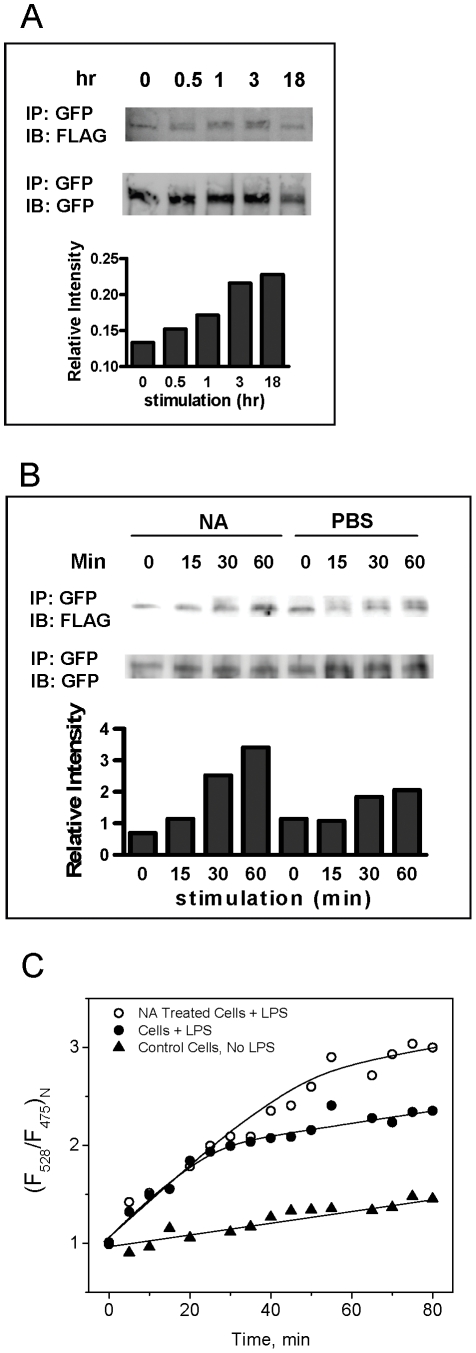
NA treatment of TLR4-expressing HEK293T cells enhanced TLR4 dimerization.HEK293T cells were transfected with mixture of expression vectors encoding TLR4-YFP, TLR4-FLAG, MD2-HA, and CD14 for two days. At indicated time points after stimulation with LPS (10 µg/ml), cell lysates were harvested and proteins were immunoprecipitated with anti-GFP antibody, separated on SDS-PAGE gels and probed on immunoblot with either anti-FLAG or anti-GFP antibodies to reveal the individual tagged TLR4 protein (A). Transfected cells were treated with either NA or PBS (as control) for 1 hour before LPS stimulation and processed as above (B). The captured images were analyzed using ImageJ (NIH, USA) and the relative intensities were obtained by dividing the mean intensity of the bands on Western blot using anti-FLAG antibody over that using anti-GFP blot. HEK293T cells were transfected with mixture of plasmids encoding TLR4-CFP, TLR4-YFP, MD2-HA, and CD14 and were maintained in culture for two days, re-suspended, and treated with NA (30 mU/ml, open circles) or PBS (filled symbols) for 1 hr. Cells were transferred to a cuvette, where they were stimulated with LPS (10 µg/ml, circles) or control PBS (triangles). The fluorescence spectrum for each sample was recorded at different time points, and the F528/F475 ratio was plotted (C). Results shown are representative of data from at least 3 independent experiments.